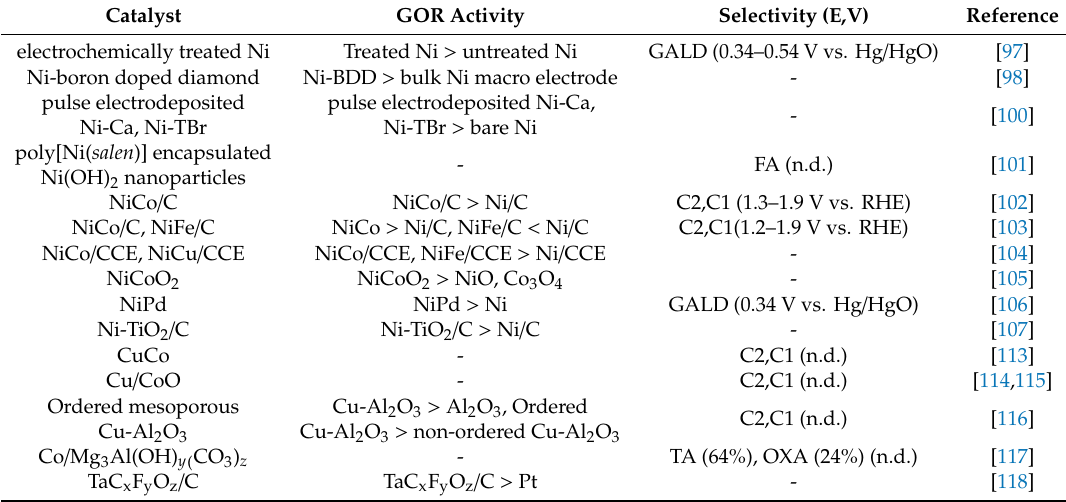
Table 3. GOR activity and selectivity in alkaline media of non-precious